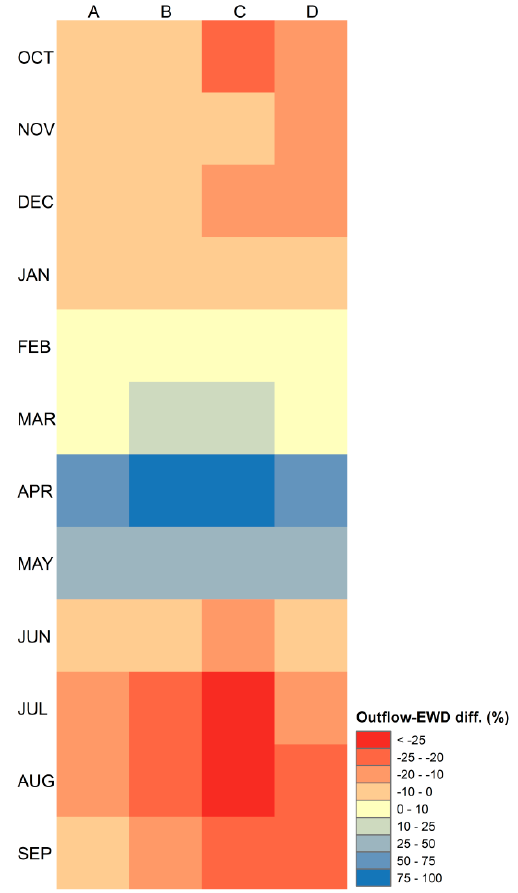
Figure 14. Mean monthly differences between outflow and EWD (2021–2050) in the four experiments.